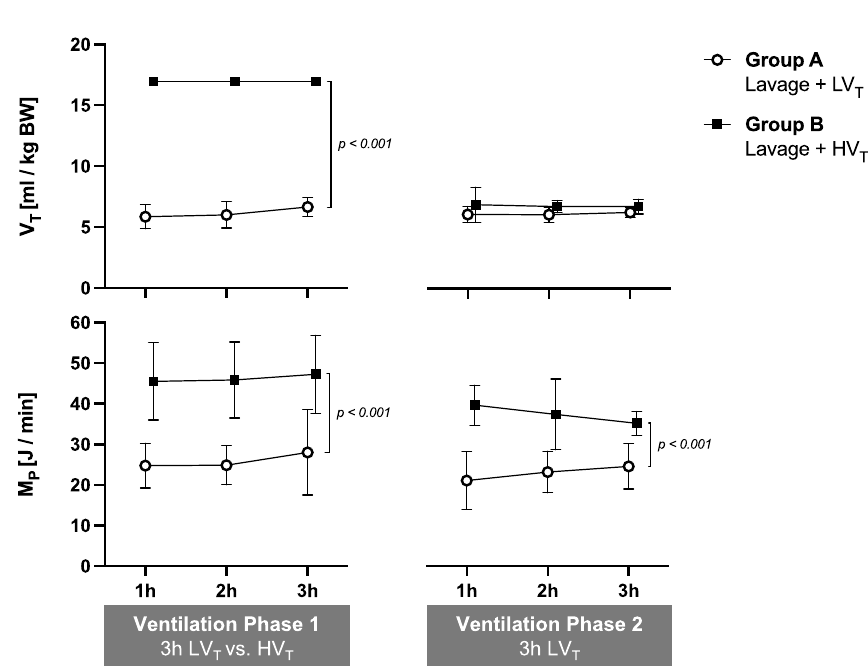
Fig. 5 Tidal volume and mechanical power in combined lavage and ventilator-induced lung injury. Tidal volume ( V T ) and mechanical power ( M P ) of ventilation were assessed in anesthetized and surfactant-depleted pigs which underwent either an automated closed-loop protective low tidal volume (6 ml/kg BW LV T ) and tabular PEEP ventilation strategy (group A) or non-automated injurious high tidal volume ventilation (HV T ) with V T of 17 ml/kg BW and PEEP 2 cmH 2 O (group B) during ventilation phase 1. Ventilation phase 2 consisted of automated LV T ventilation in both groups ( N 6 each). Two animals died after injurious HV T and RM 2, i.e., = Group B, N 4 during ventilation phase 2. For experimental protocol, see Fig. 1 and “Methods” Section. For = calculation of the M P , the simplified equation proposed by Becher et al. for pressure-controlled ventilation is used (see “Methods” Section in the main text). Means SD; p -values indicate significant group effects and ± were calculated using two-way ANOVA-type nparLD package (see Table 2, associated relative treatment effects (RTE) see Additional file 1: Table S2a). For more statistical details refer to main